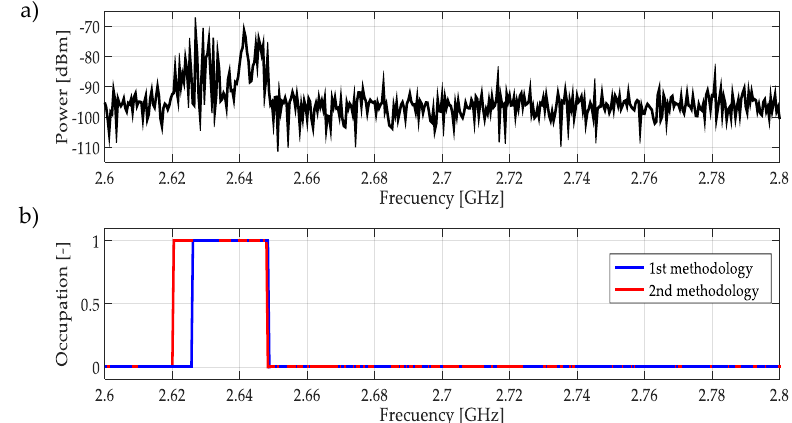
Figure 25. ( a ) A real signal obtained from the frequency band [2.3 – 2.5] GHz. ( b ) The result of applying both methodologies to the real signal in terms of spectrum occupancy. In this case, the first